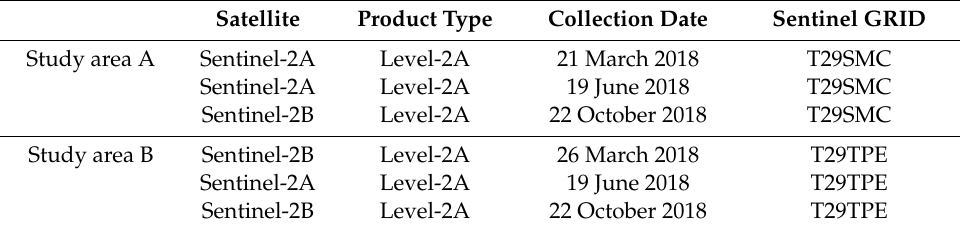
Table 2. Details about the bands and images used for the analysis made in each study area.